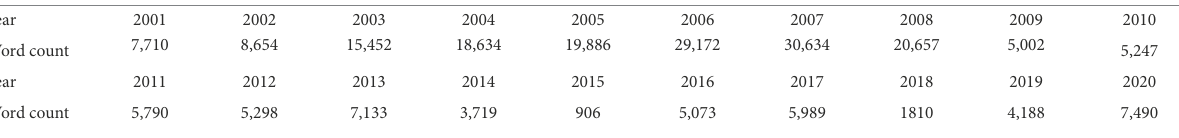
TABLE 1 Word count for each year’s CSR